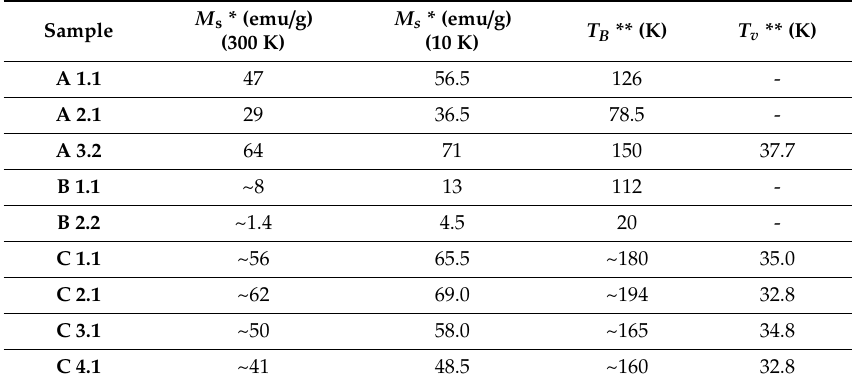
Figure 7. Field dependence of magnetization for the naked SPIONs (Samples A): ( a ) magnetization curve up to 5 T at 300 K, ( b ) hysteresis cycle at 300 K, ( c ) hysteresis cycle at 10 K. Table 5. Magnetic parameters, estimated from the DC magnetization (saturation magnetization, Ms) and AC susceptibility (blocking temperatures, T B , and Verwey temperatures, T V ) measurements of the naked and coated SPIONs (samples, A, B, and C).